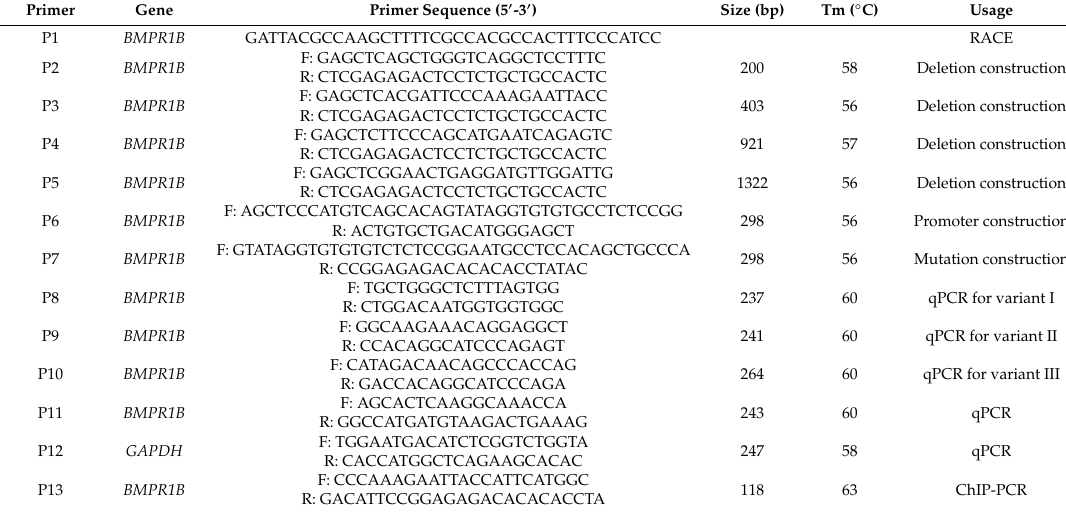
Table 1. The primer